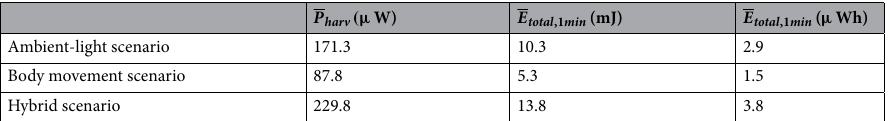
Table 3. Summary of system performance for all indoor scenarios (average harvested power P harv ) and average total harvested energy E total